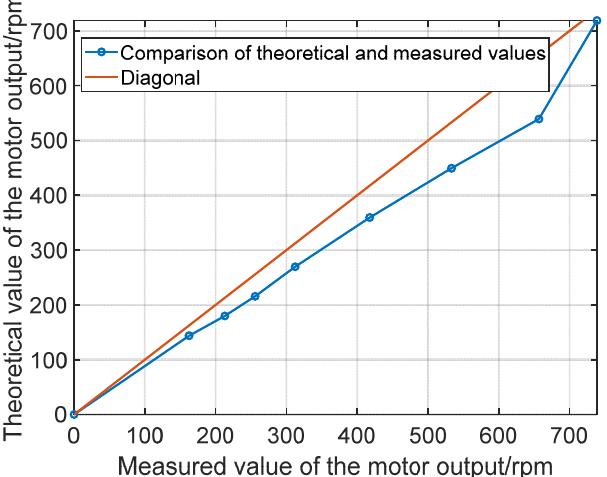
Figure 9. The comparison of theoretical and measured values for output speed of pump–motor system.